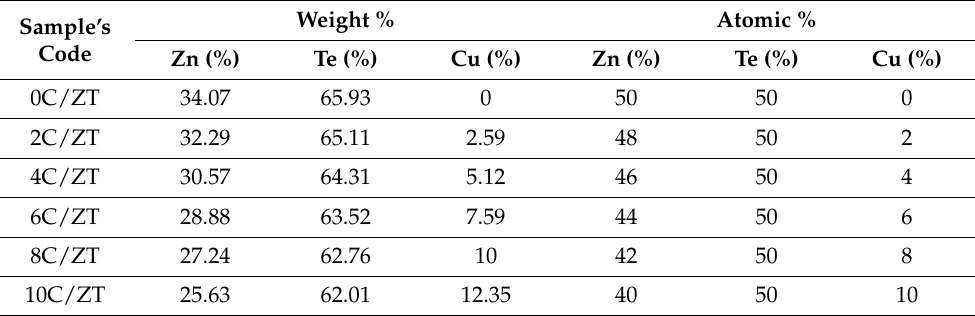
Figure 2. Rietveld refinement of ZnTe powder sample.